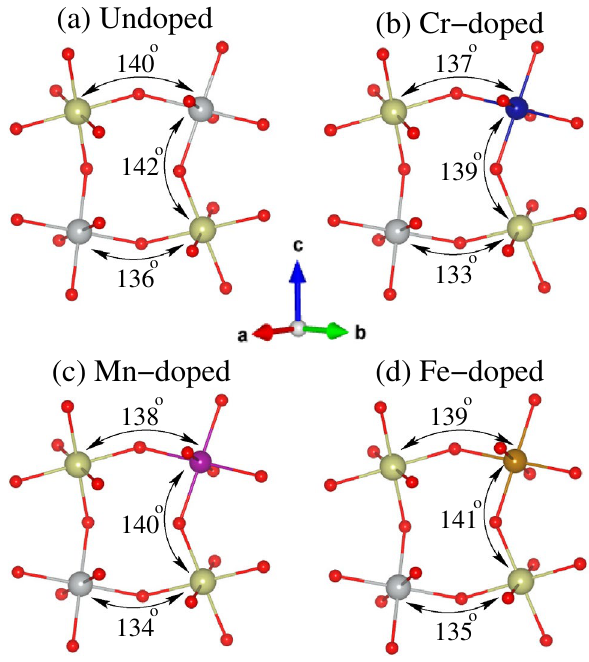
Figure 3. A crystallographic view of the crystal structure of ( a ) undoped, ( b ) Cr-doped, ( c ) Mn-doped, and Fe-doped Lu 2 NiIrO 6 double perovskite oxides along with DFT relaxed three peculiar Ni(TM)-O-Ir bond